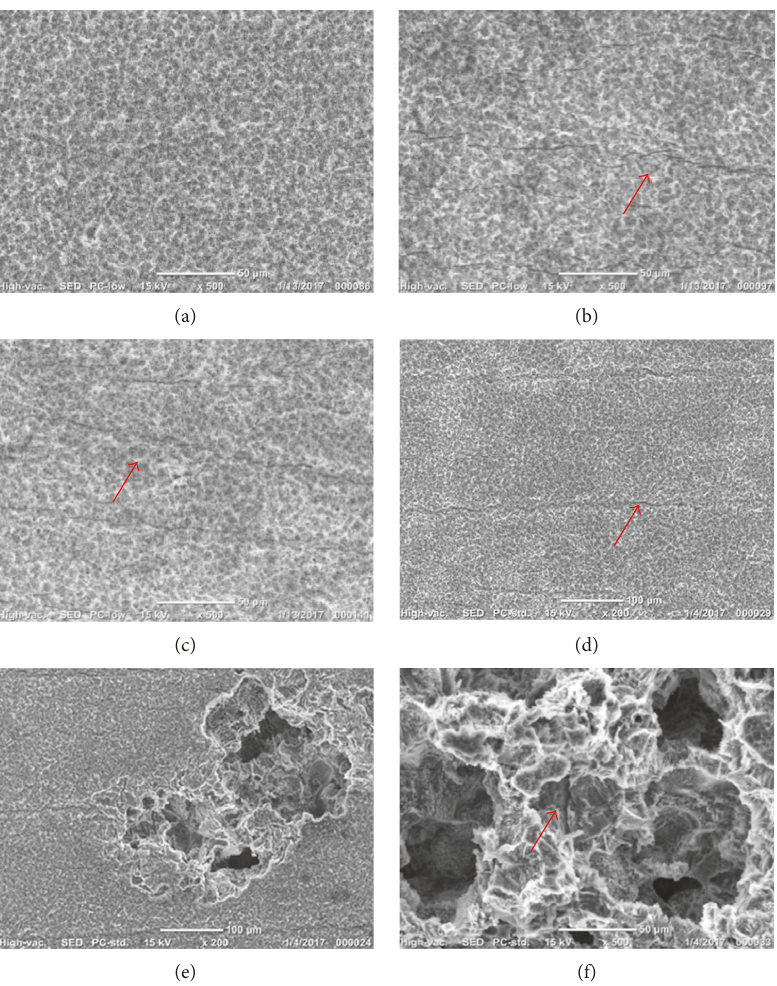
Figure 8: SEM micrographs of the AQ80M alloy with MAO coating under different strains: (a) 0.3 σ (c) 0.6 σ 0.2 120h, (d) 0.75 σ 0.2 120h, (e) 0.75 σ 0.2 120 h, and (f) 0.75 σ 0.2 × × ×